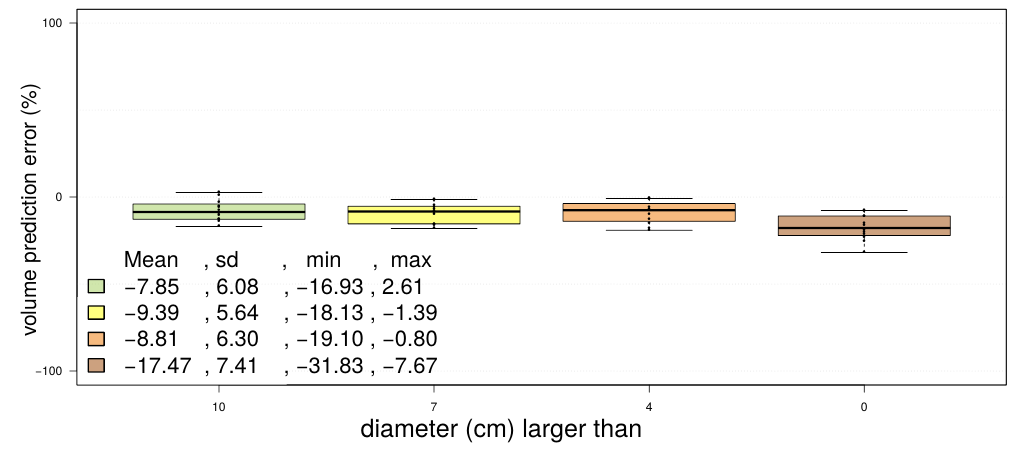
Figure 9. Box plots of the relative volume prediction error for E. fordii . From left to right increasingly thinner branches are included in the